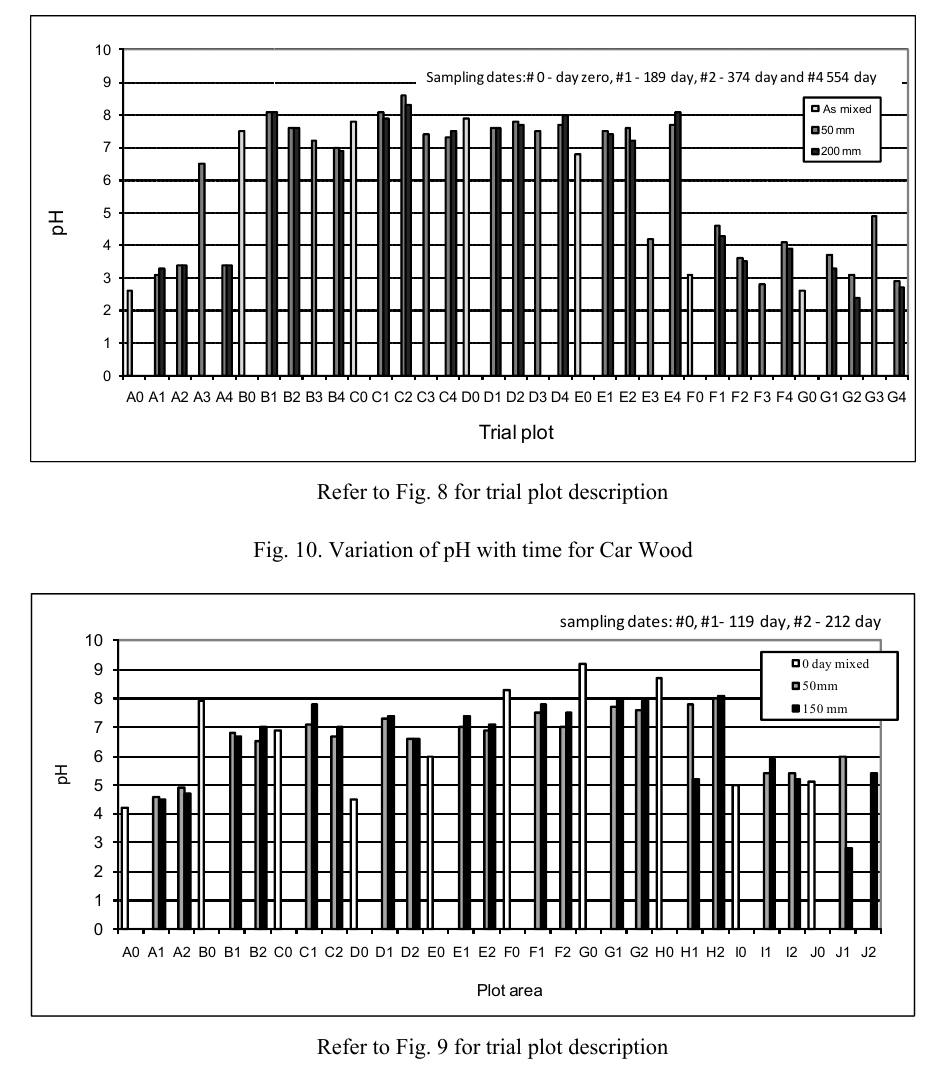
Fig. 11. Variation of the pH with time for Derwent Forest